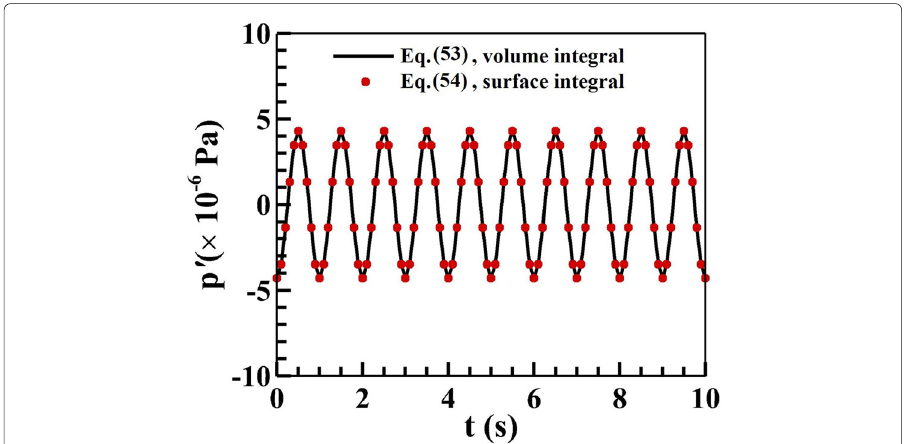
Fig. 11 Contribution to far-field acoustic pressure from the homogeneous vortical flow computed by using ( a ) the volume integral (Eq. (53)) and ( b ) the surface integral (Eq.